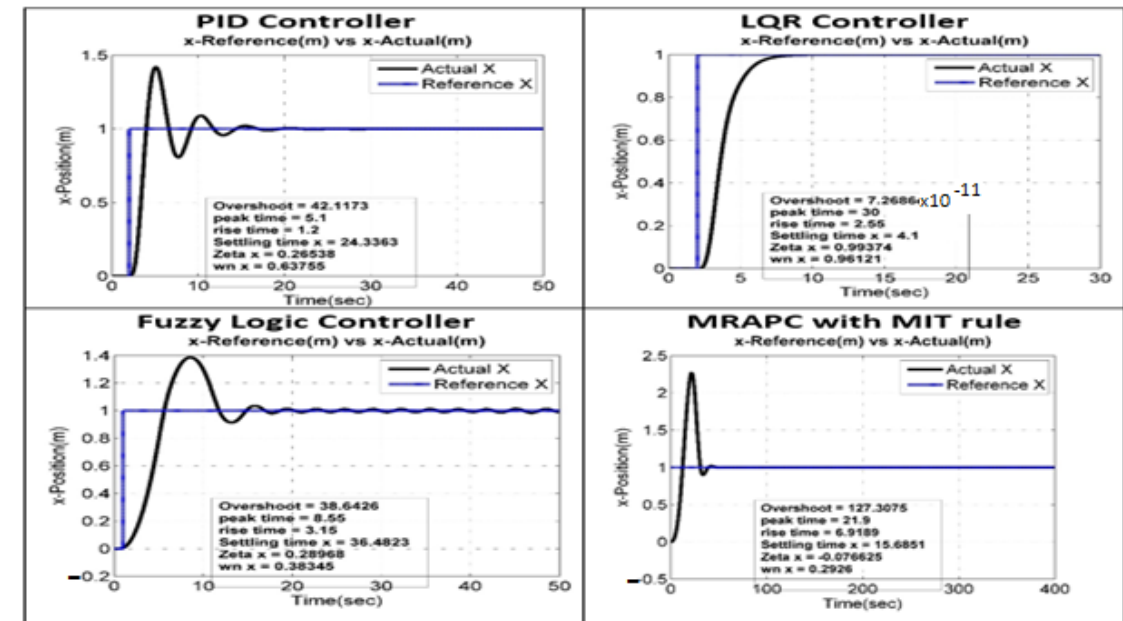
Figure 13. Step response result of all control systems along the x − axis.